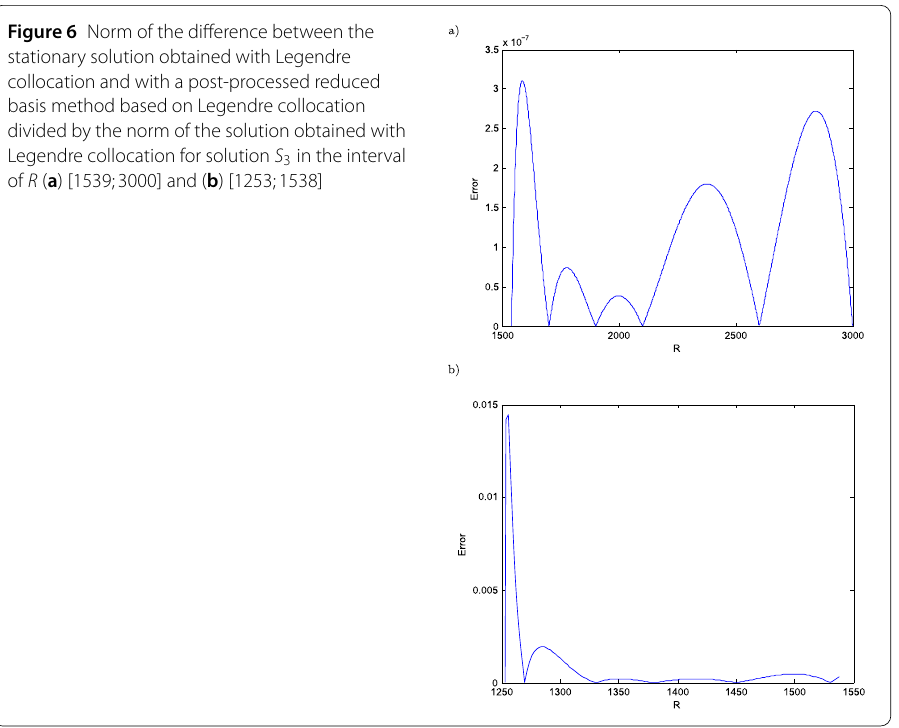
Figure 6 Norm of the difference between the stationary solution obtained with Legendre collocation and with a post-processed reduced basis method based on Legendre collocation divided by the norm of the solution obtained with Legendre collocation for solution S 3 in the interval of R ( a ) [1539;3000] and ( b )